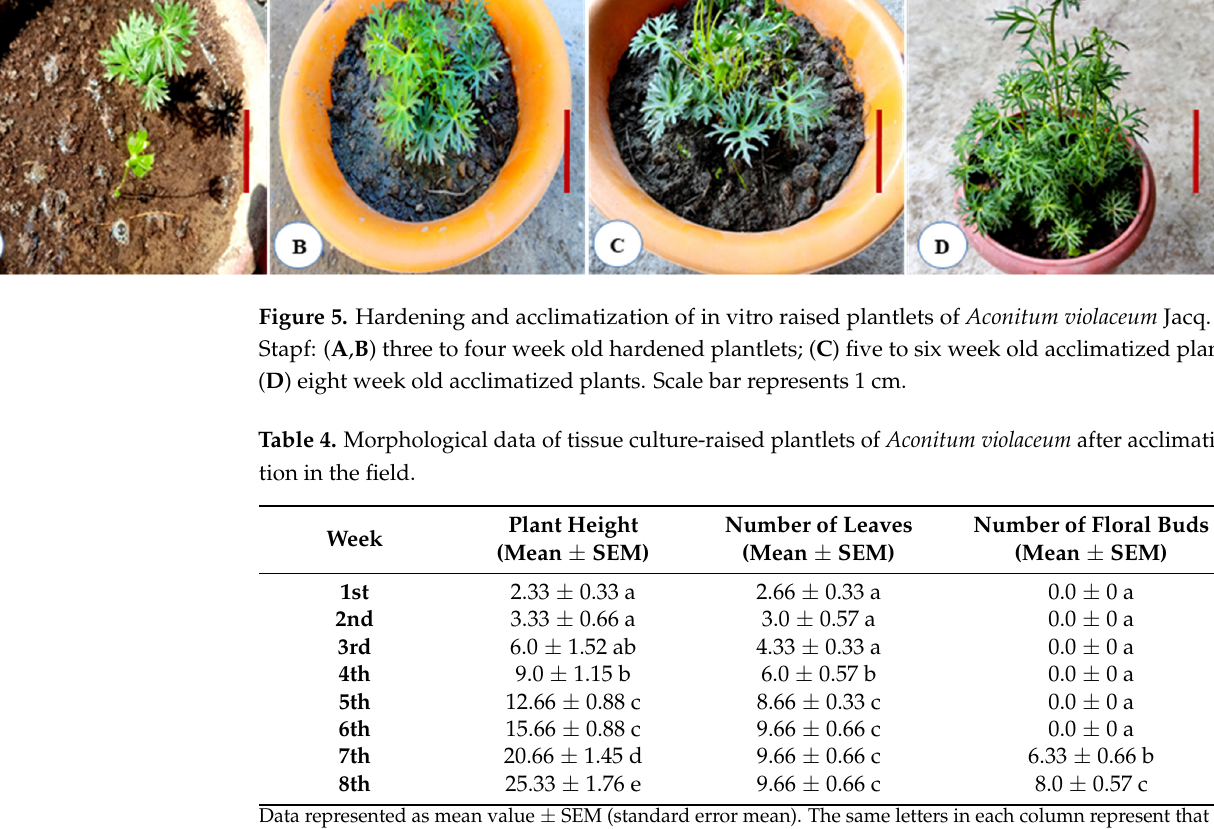
Data represented as mean value ± SEM (standard error mean). The same letters in each column represent that the data were not considerably different according to DMRT (one-way ANOVA) at p ≤